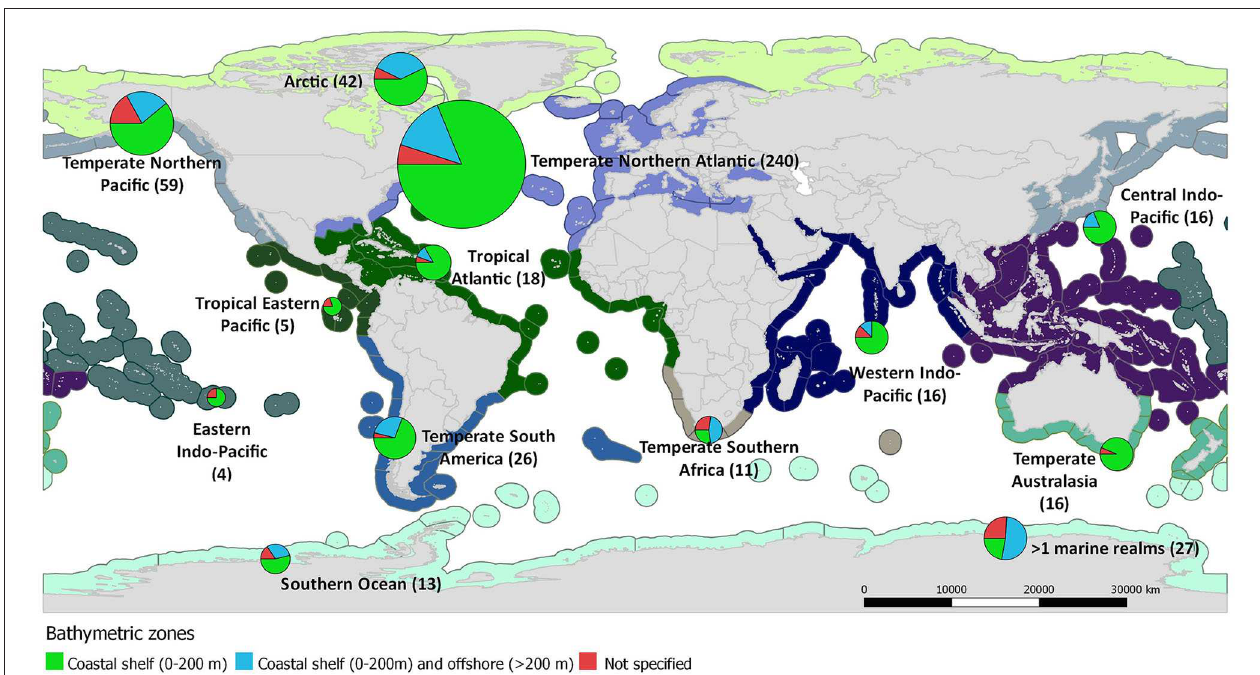
FIGURE 3 | World map depicting the number of coastal shelf food web studies ( N = 493) that have been carried out per marine realm (depicted with different color in the map; sensu Spalding et al., 2007). Pie charts represent the proportion of studies conducted per bathymetric zone.